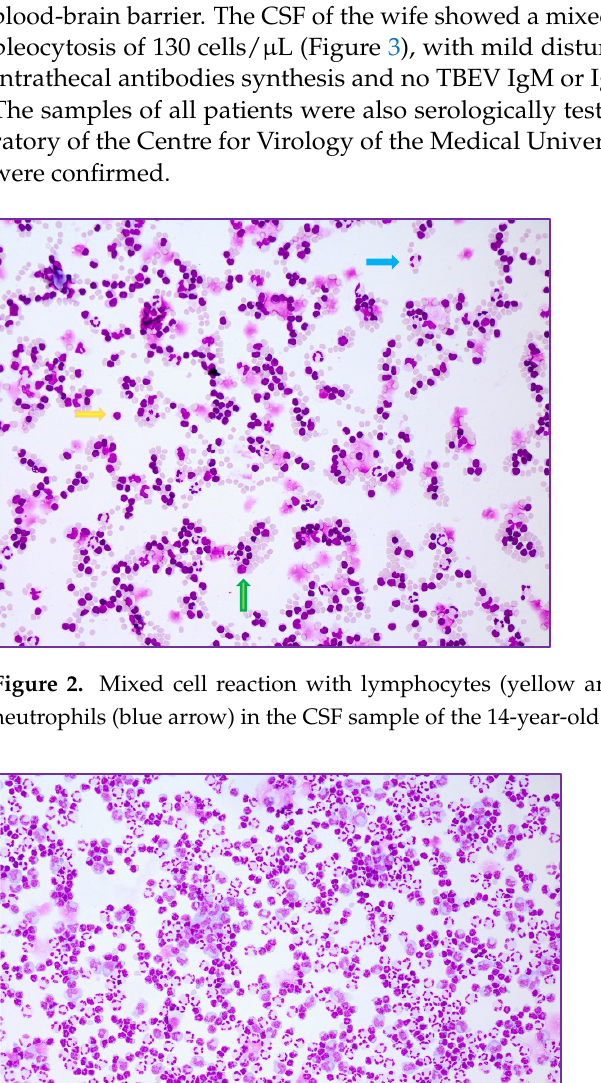
Figure 1. Mild mixed pleocytosis with leukocytes, monocytes and some neutrophils in the CSF of the index patient (20× magnification).